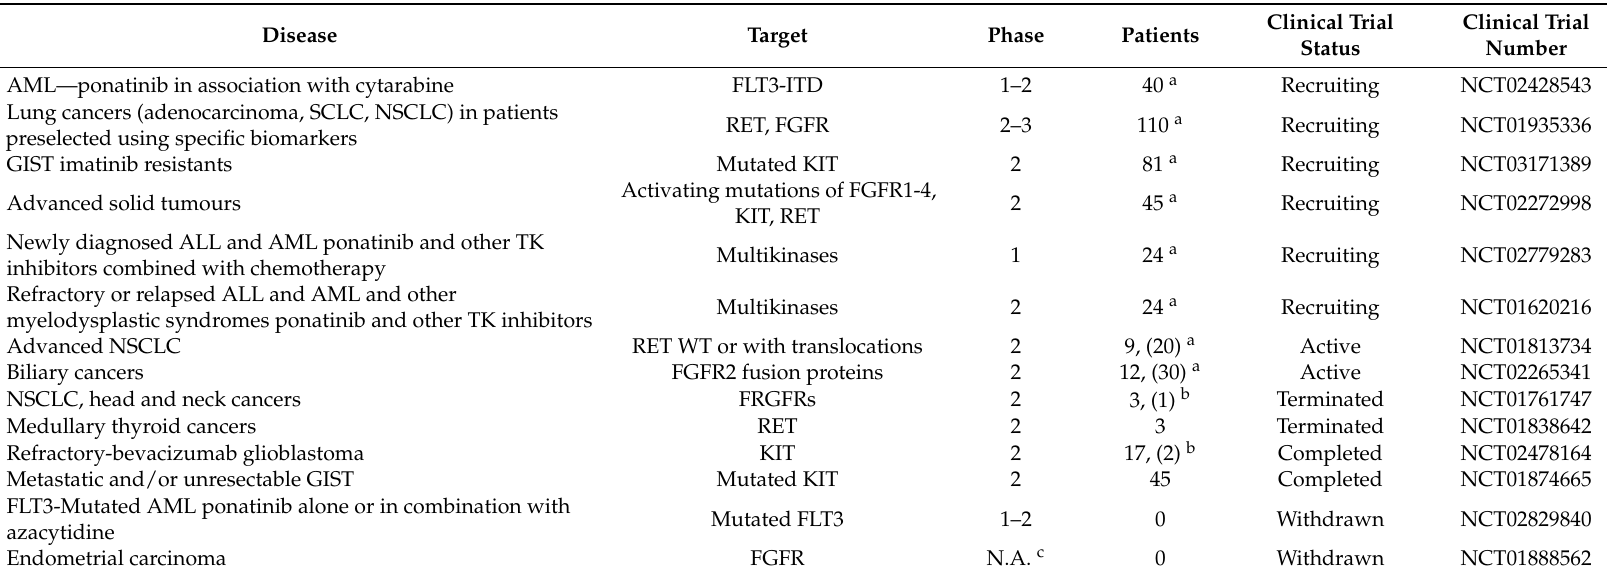
Table 2. Clinical trials and their status on ponatinib, in disease other than